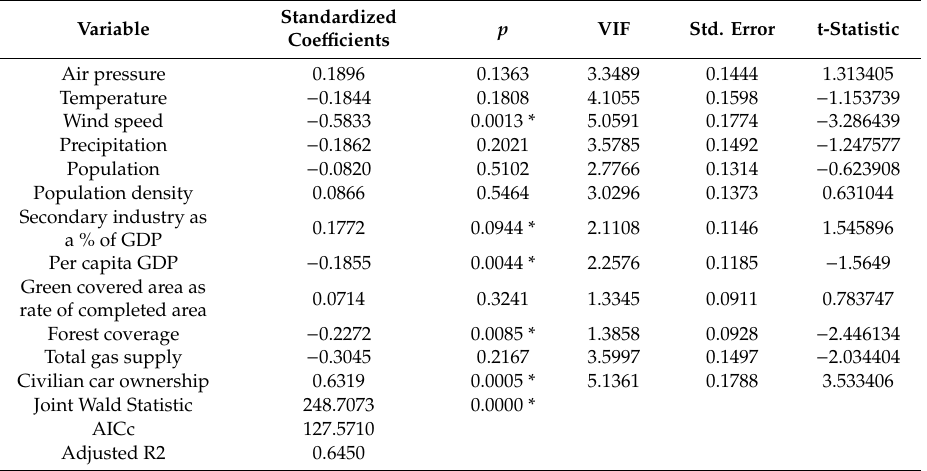
Table 3. Overall results of OLS